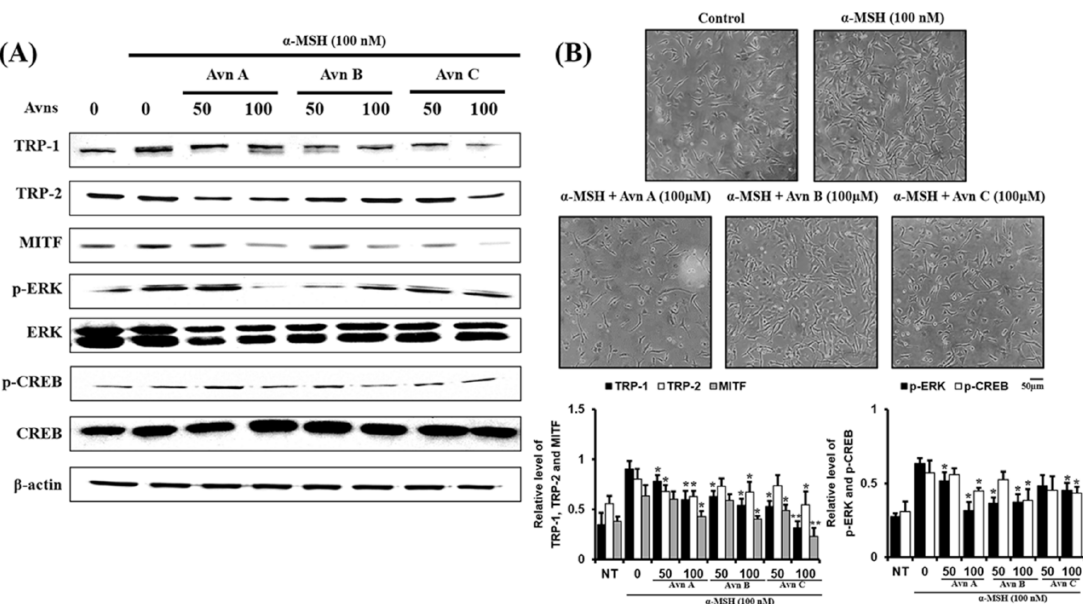
Figure 4. Inhibitory effect of AvnA, AvnB, and AvnC on melanogenesis-related protein expression and dendrite extension in α -MSH-activated SK-MEL-2 cells. ( A ) Avn-A-B-C on expression of melanogenesis-related proteins such as TRP-1, TRP-2, MITF, p-ERK, and p-CREB by Western blotting. Cells were treated with compounds at 0, 10, 25, 50, and 100 µ M. ( B ) Cell morphology of micrograph (scale bar is 50 µ m). Avn-A-B-C on dendrite extension in SK-MEL-2 cells. Cells were treated with compounds at 100 µ M. The results shown are mean ± SEM and represent three independent tests. * p < 0.05 and ** p < 0.01 = significant differences from the α -MSH treated